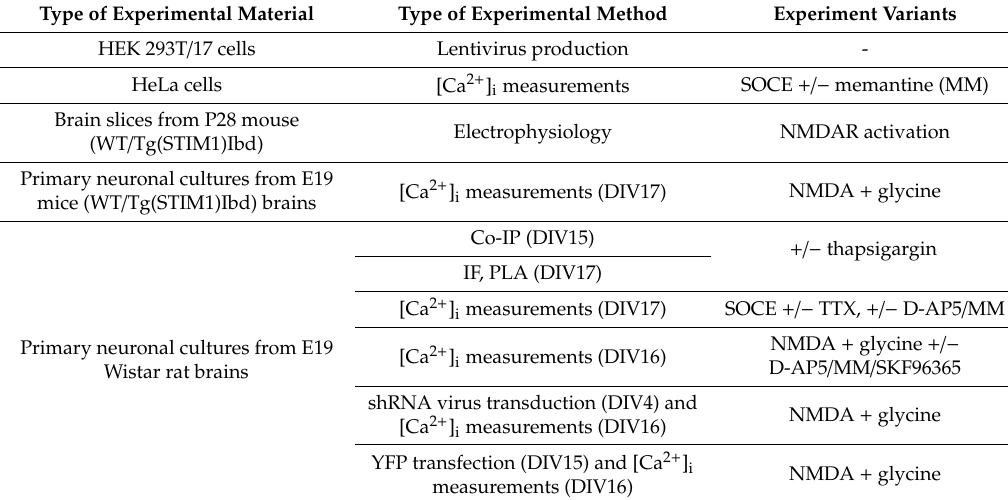
Table 1. Experimental